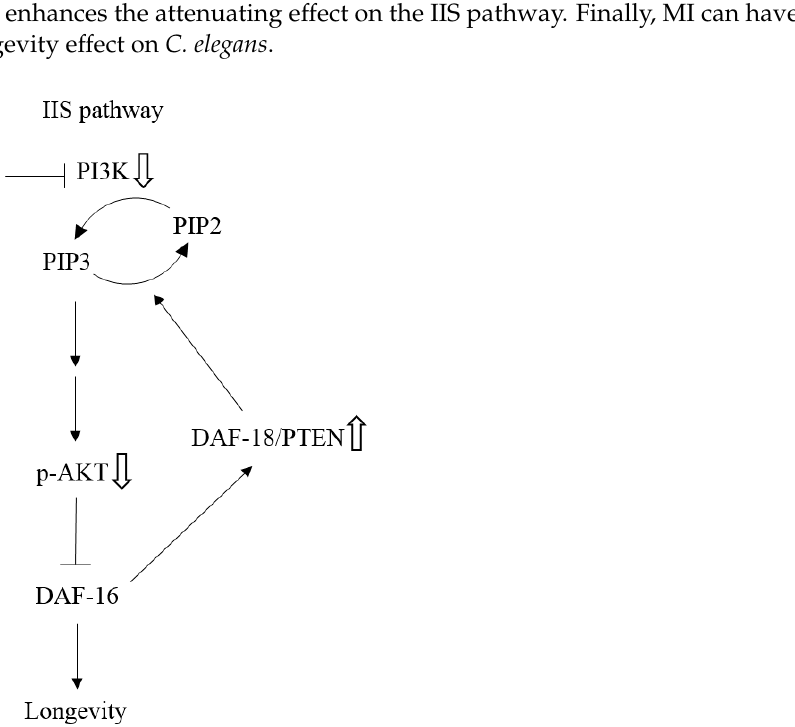
mophenol blue and sodium azide were obtained from Sigma (St. Louis, MO, USA).